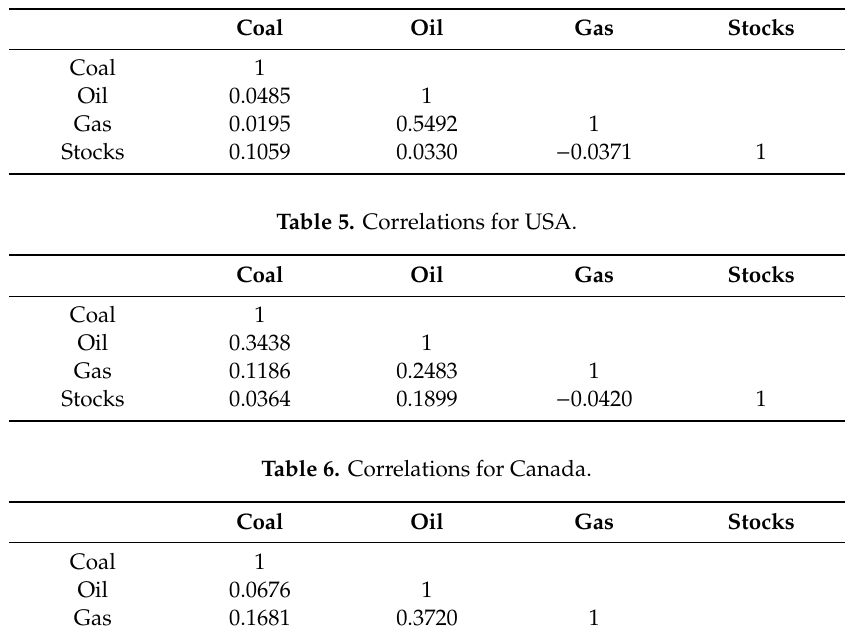
Table 4. Correlations for Europe.